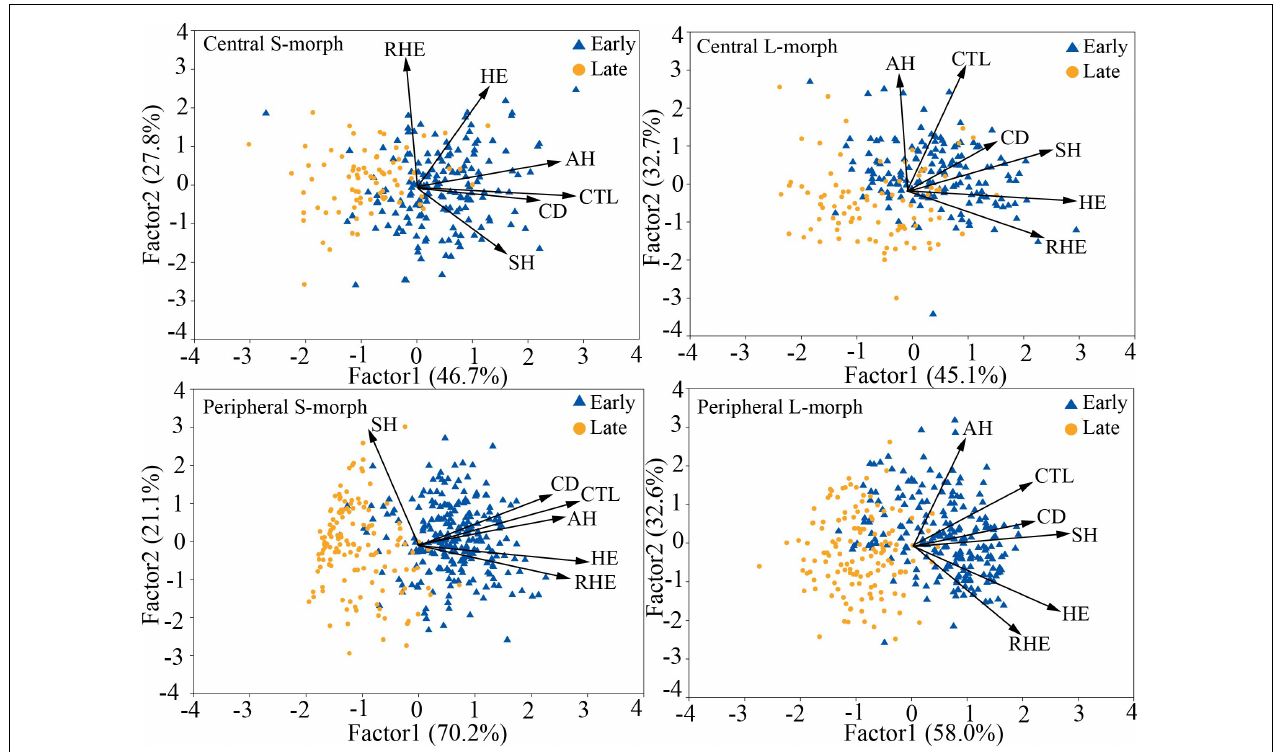
FIGURE 2 | PCA biplots of six floral traits of L- and S-morphs of P. wannanensis at early and late florescence stages at different sites. SH, stigma height; AH, anther height; CTL, corolla tube length; HE, herkogamy; RHE, relative herkogamy; CD, corolla